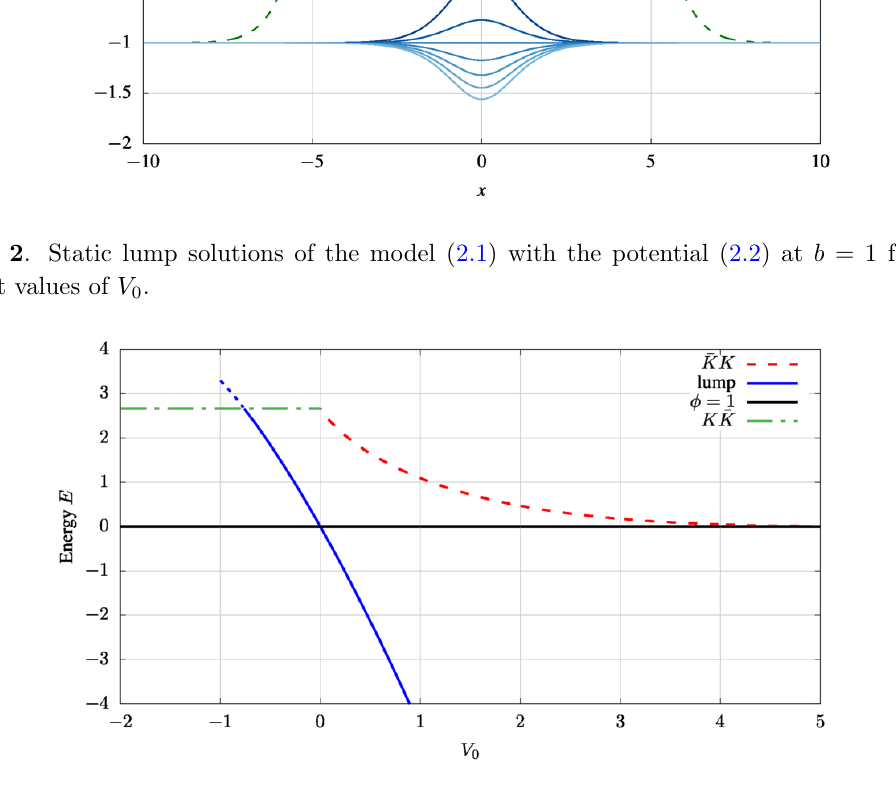
Figure 3 . Energies of the static solutions of the model (2.1) vs V 0 . Dashed curves correspond to the unstable solutions, see (cid:12)gures 1 and